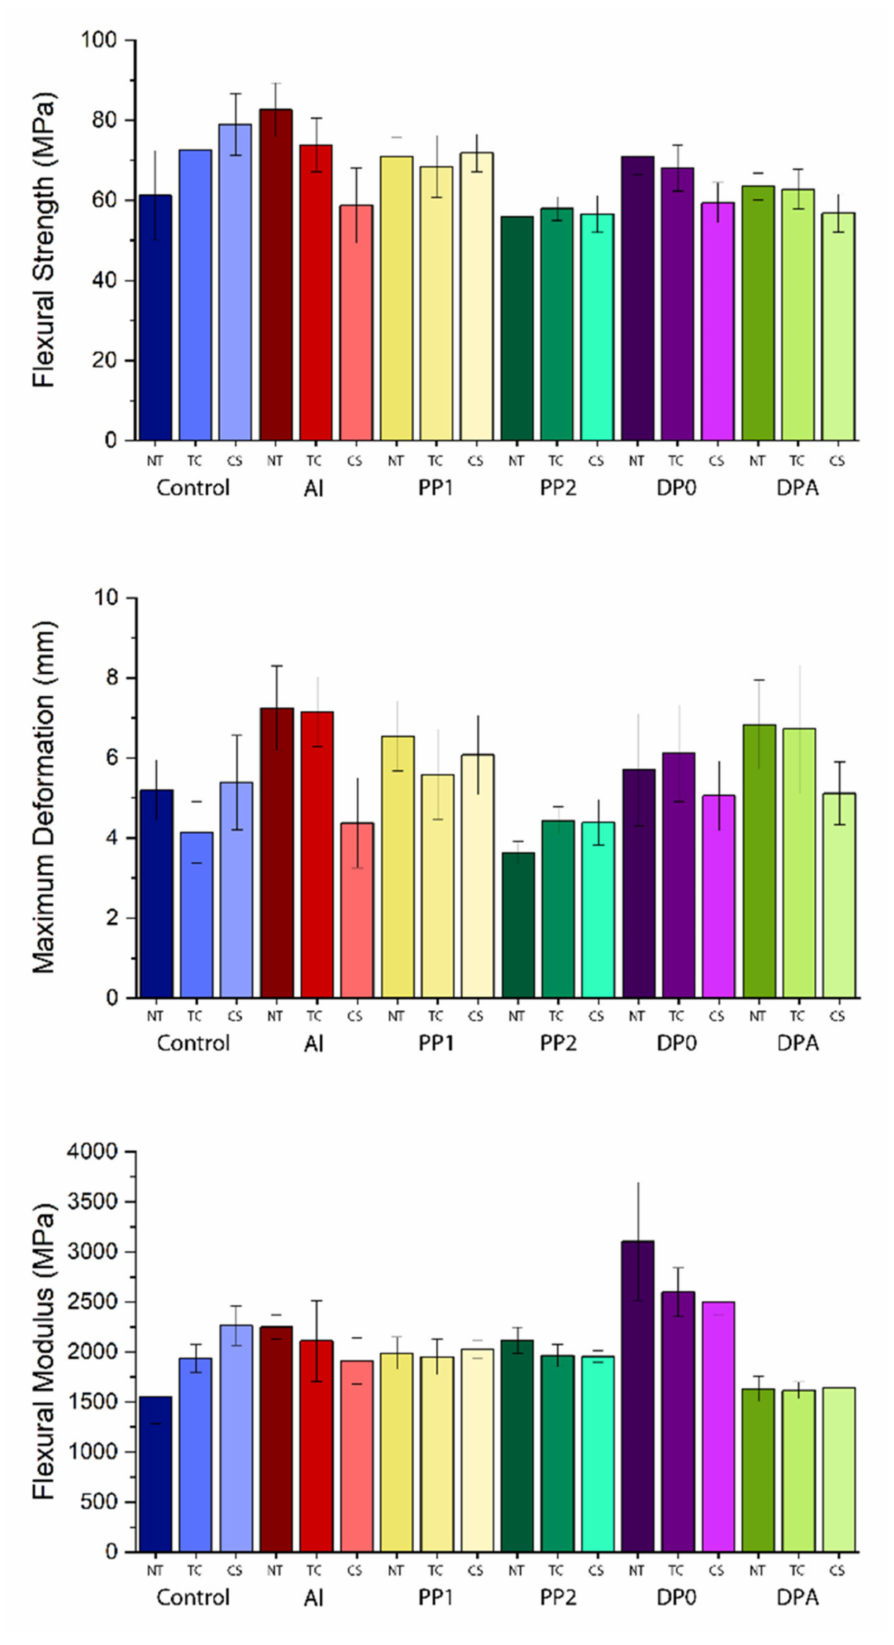
Figure 2. Test specimens before and after the three-point bending